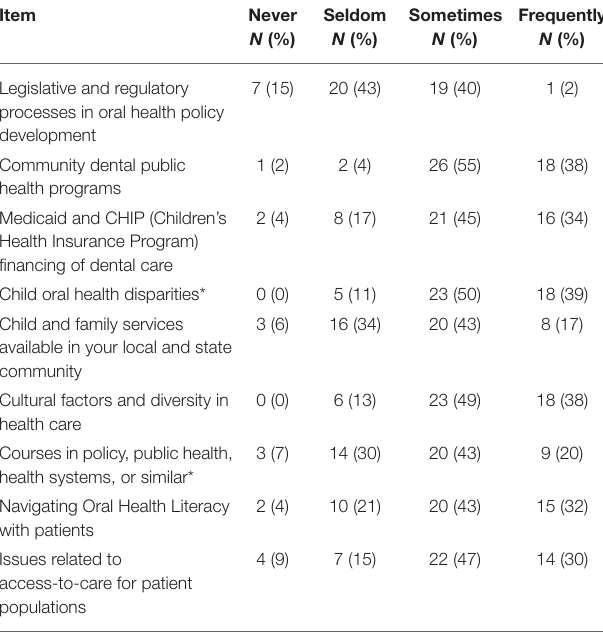
TABLE 1 | Dental Student’s Attitudes toward, Advocacy (Total N = 47). Item Strongly Disagree Advocacy for the oral health of my community beyond the dental school and dental clinic is an appropriate role for dental students.